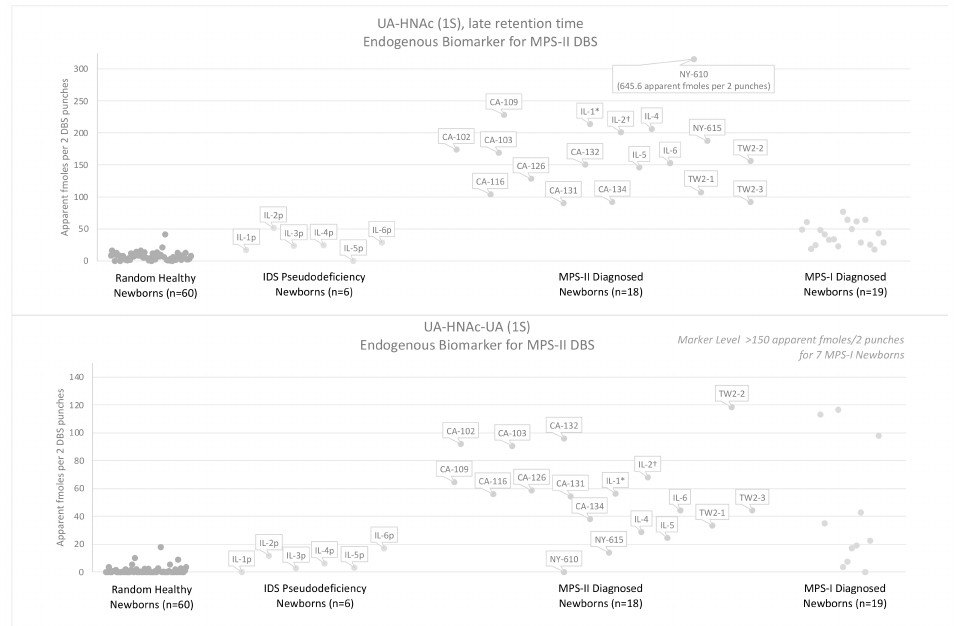
Figure 7. Levels of the MPS-II endogenous disaccharide UA-HNAc(1S)-late and trisaccharide UA-HNAc-UA(1S) biomarker PMP derivatives in newborn DBS from 60 random newborns (non- MPS), from 6 newborns with an IDS pseudodeficiency, from 16 newborns with severe MPS-II, 1 newborn with undetermined MPS-II phenotype, 1 newborn with attenuated MPS-II, and 19 new- borns with MPS-I (previously reported [16]). * DBS from patient with undetermined phenotype, † DBS from patient with attenuated phenotype, Label key and DBS storage conditions: CA = Califor- nia (frozen), IL = Illinois (frozen), TW = Taiwan (frozen), NY = New York (ambient).